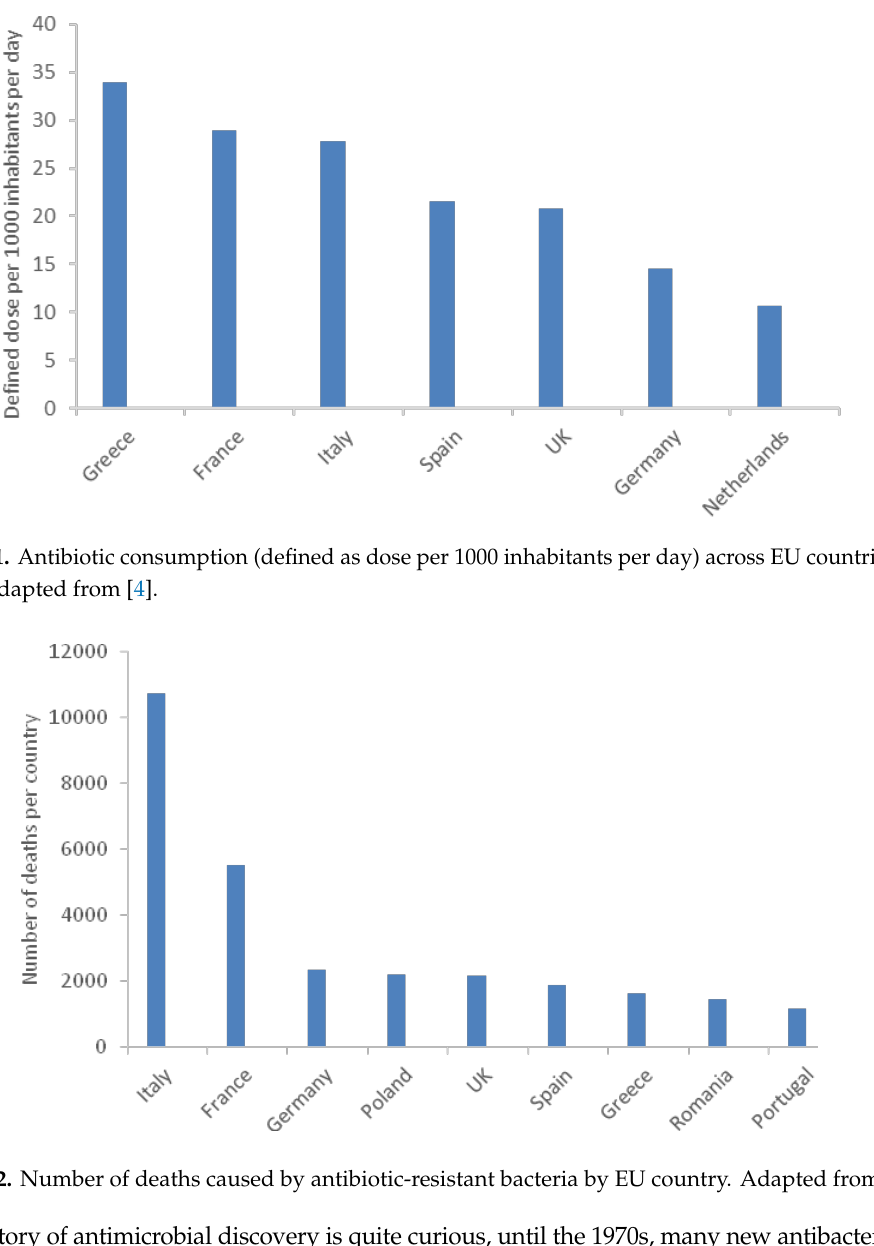
Table 3. Dates of discovery of the classes of antibacterial drugs.